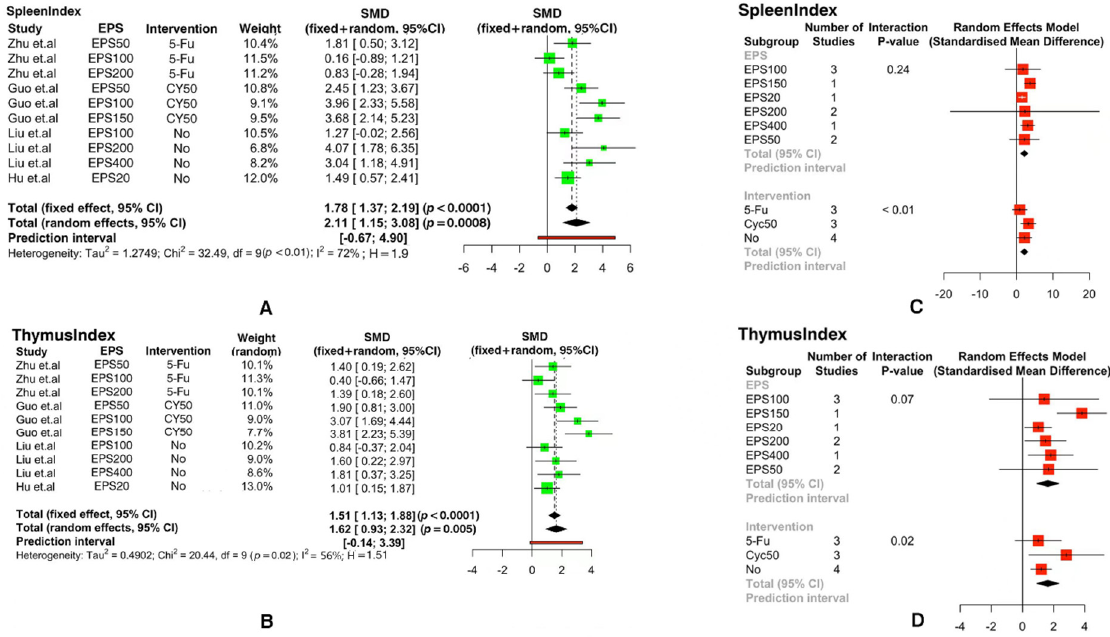
Figure 2. The forest plot illustrates the effects of extra-cellular polysaccharides on the immunity index of animals: ( A ) spleen index, ( B ) thymus index. Based on the above figure, a forest plot of the effect of using interfering media before EPS treatment and the effect of different concentrations of EPSs on immunity index was made: ( C ) spleen index, ( D ) thymus index. (Positive and negative values in-dicate increases or decreases in the production of immune factors. SMD: standardized mean dif-ference.)